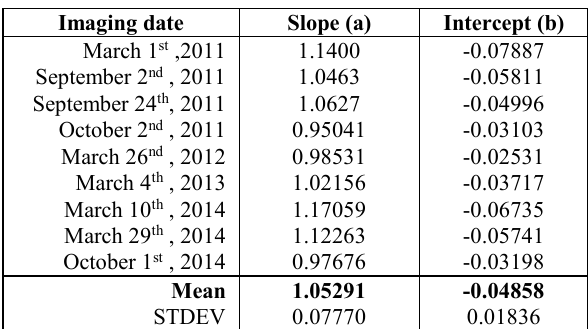
Table 2. Bare soil line characteristics of multi-temporal images and the mean values used for estimating GGC% from RapidEye images.